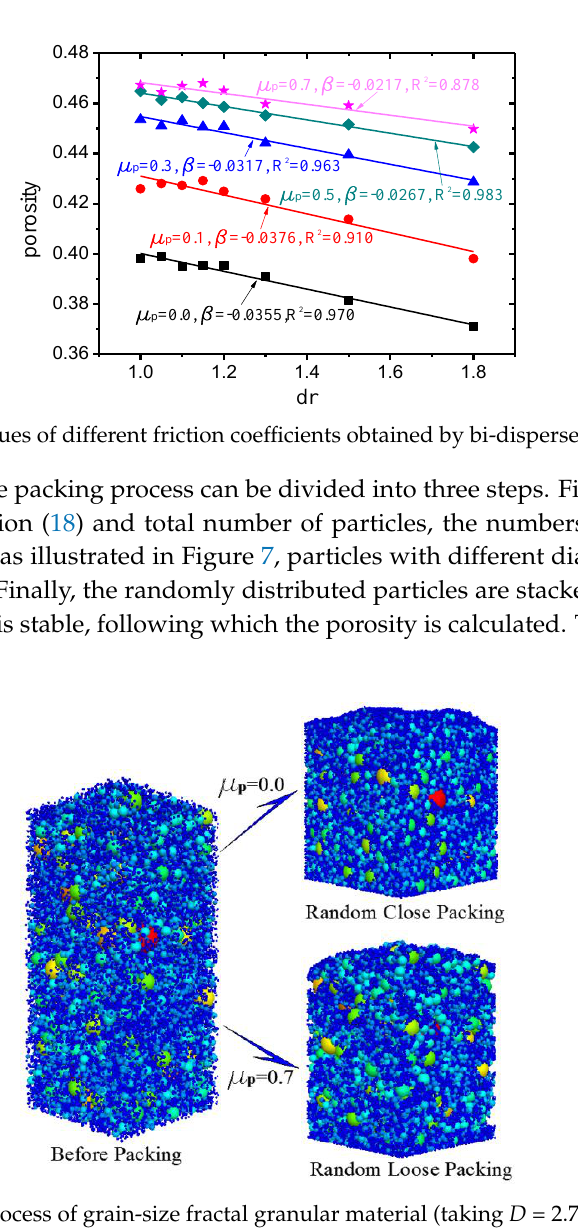
Figure 7. Packing process of grain-size fractal granular material (taking D = 2.7 as an